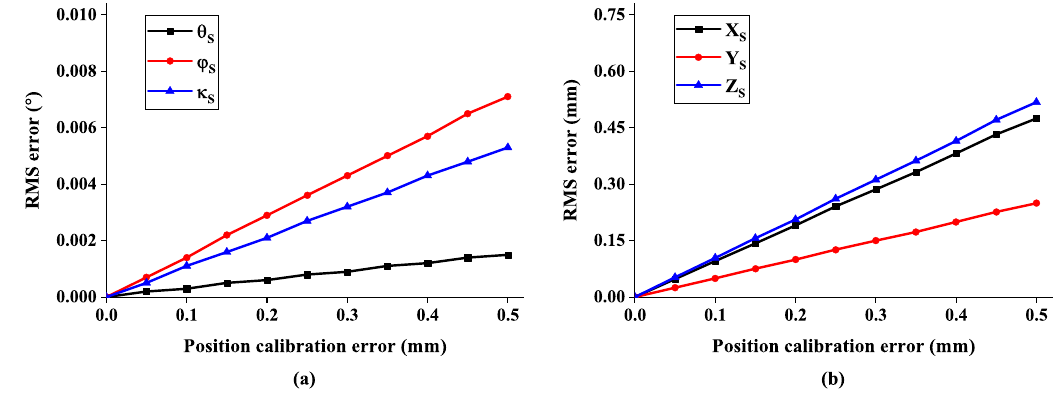
Figure 12. The RMS error of 6-DOF with respect to position calibration error: ( a ) the error of rotation angle and ( b ) the error of system position.